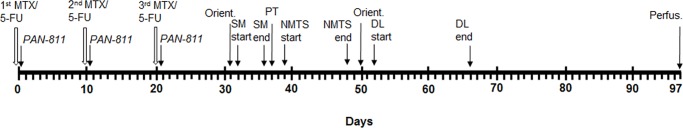
Experimental timeline.A combination of 5-FU and MTX or equal volume of physiological saline was administered to 3-month old rats, i.p., 3 times at 10-day intervals, and PAN-811 or equal volume of saline was injected, i.p., 10 min following each anticancer drug administration. Chemo: MTX/5-FU; PAN: PAN-811; Inject: injection; Orient.: Orientation; SM: spatial memory test; PT: probe test; NMTS: nonmatching-to-sample test; DL: discrimination learning test; Perfus.: perfusion; IHC: immunohistochemistry.